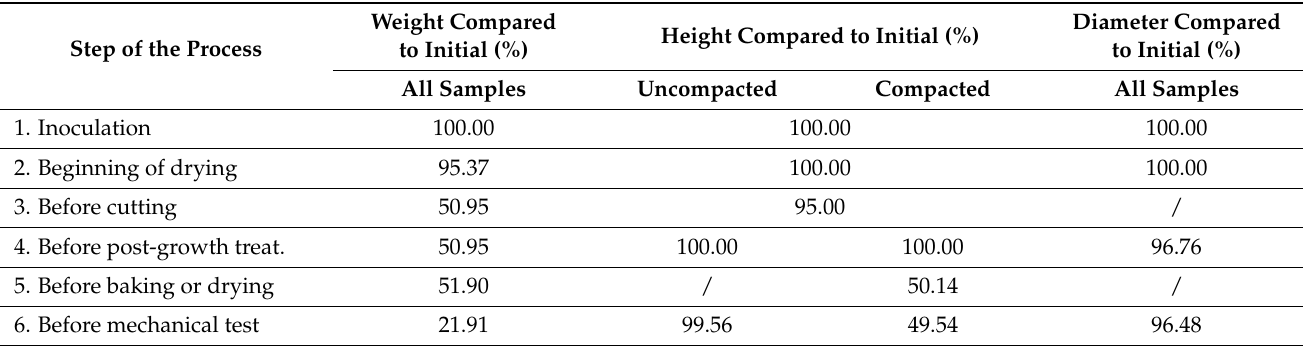
Table A1. This table shows the evolution of the weight, height, and diameter from inoculation to the beginning of compression testing. Specimens were cut between steps 3 and 4. The weight was therefore kept between these two steps to ensure the comparison was continuous. The height was reset to 100% once the specimens were